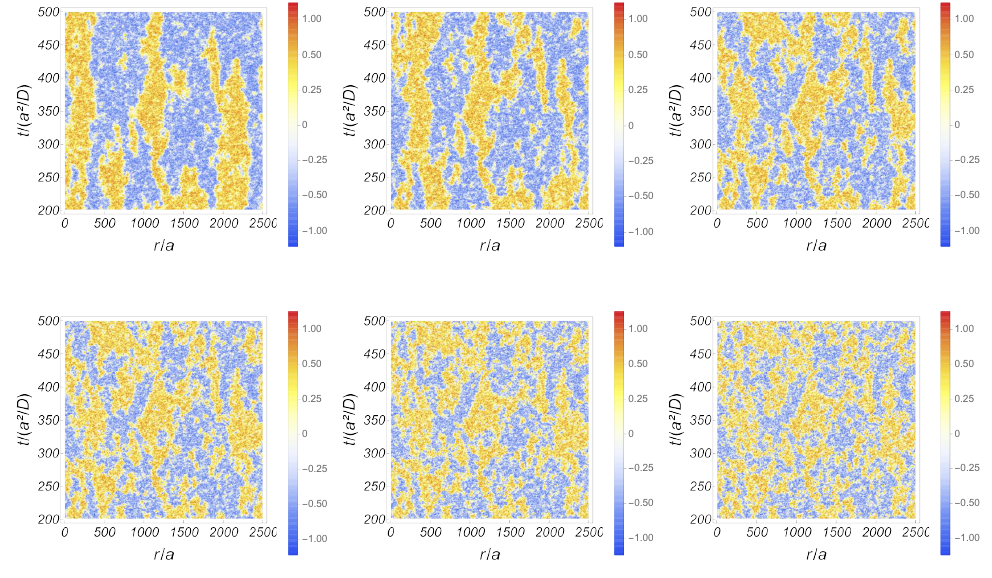
Figure 4: Local magnetization of the hydrodynamic theory, Eq. (15), at differ- ent coupling strengths ˜ ε = 0.1,.125,0.15 (first row) and ˜ ε = 0.175,0.2,0.225 (cid:0) (cid:1) ˜ ε = ( Ja 2 / D ) ε (second row), , as a function of space r and time t in units of a and a 2 / D ,